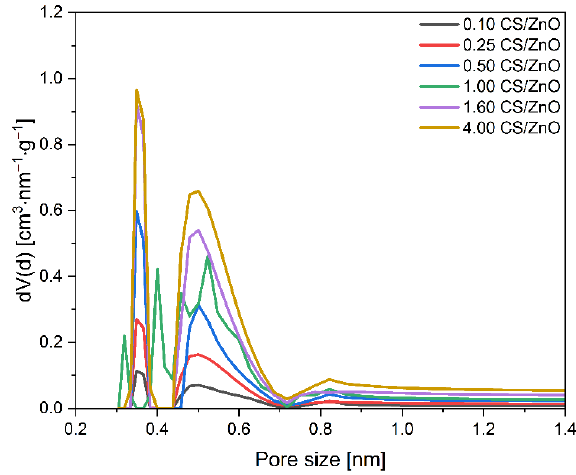
Figure 10. Pore size distributions of the obtained CS/ZnO composites.